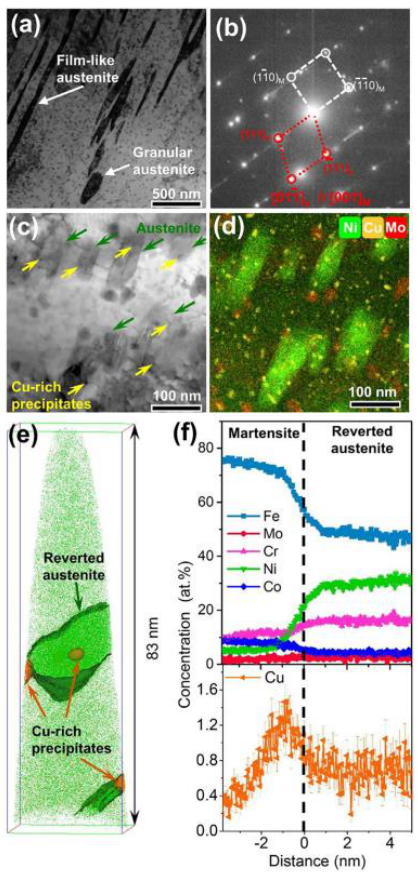
Figure 3. Microstructural characterization results of reverted austenite before deformation [96]: ( a ) The TEM image of the Cu-containing steel in the 60 h aging treatment, ( b ) the SAED pattern corresponding to the orientation relationship between the reverted austenite and matrix in ( a ), ( c , d ) are the brightfield TEM micrograph and corresponding TEM/EDS mappings of Ni, Cu, and Mo, respectively, and ( e , f ) are the microstructure and compositions of Cu-rich precipitates and reverted austenite employed by APT. (Reprinted with permission from Ref. [96]. Copyright 2022 Elsevier).